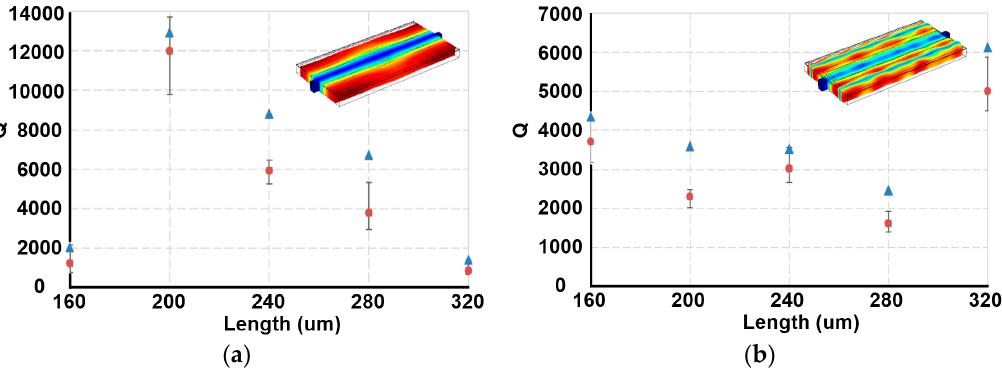
Figure 2. Simulated and measured Q values of PSBARs with different length. The width is 120 μ m. Q values of ( a ) first order width-extensional mode (WE mode) and ( b ) third order WE mode. The triangle markers represent simulation results. The insets are the displacements of PSBARs at the first and third order WE modes.